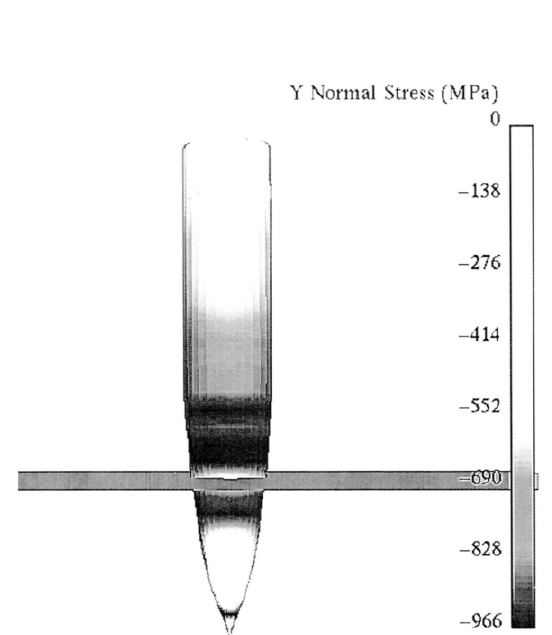
FIGURE 9 Distribution of Y-normal stress